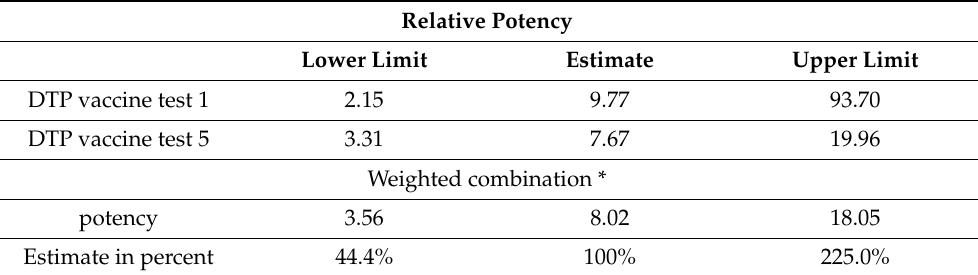
Table 4. Estimation of the weighted geometric mean of the relative potency of the pertussis component of DTP vaccine tested (DTP vaccine test 1 and vaccine test 5). Statistical analysis for homogeneity ( p ≥ 0.05) was performed using the chi-squared test under WHO combistats software.